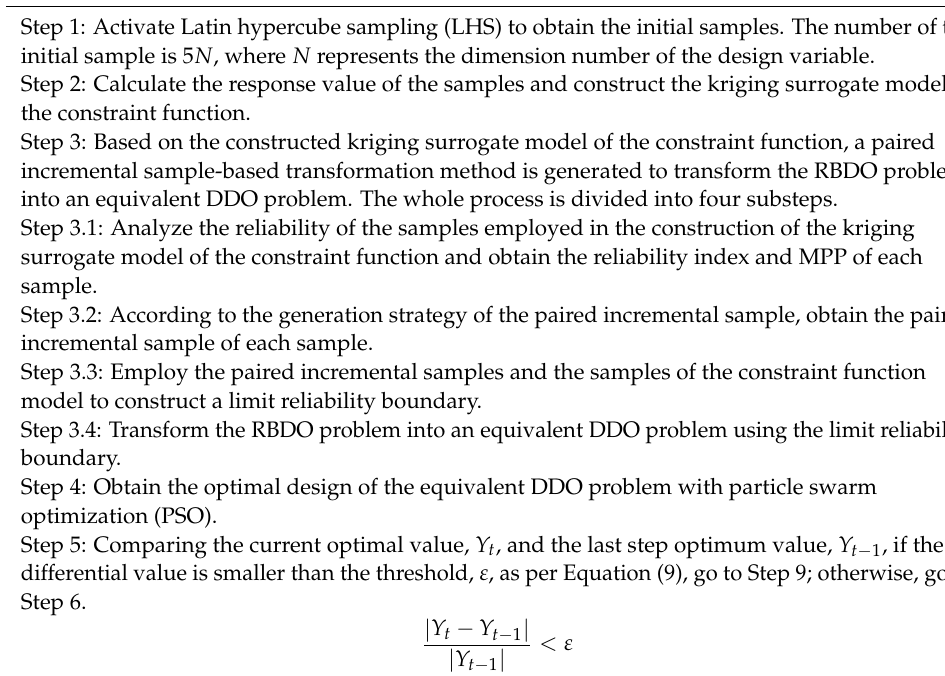
Algorithm 1 Algorithm flow for black box RBDO